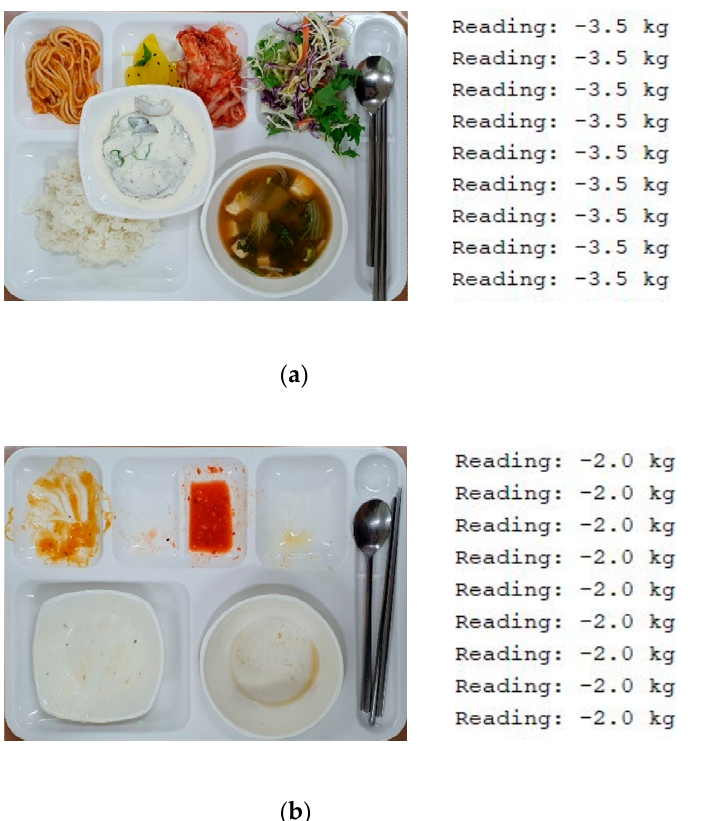
Figure 3. Meal weight measurements with no calibration factor: ( a ) initial meal and ( b ) after the meal